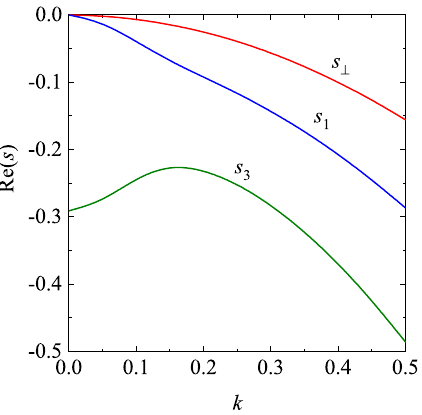
Figure 2. Dispersion relations for a granular fluid with α = 0 . 8 and φ = 0 . 2. From top to bottom the curves correspond to the d 1 degenerate shear (transversal) modes and the remaining lon- − gitudinal modes. Only the real parts of the eigenvalues is